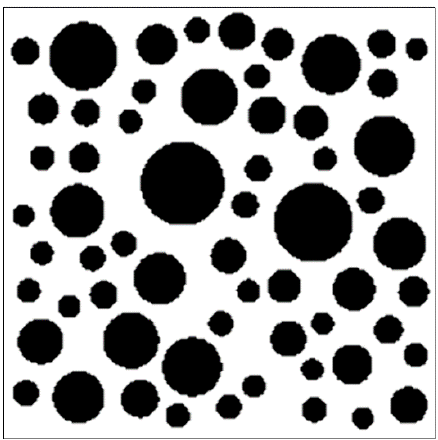
Figure 6. The reconstructed bi-dispersed porous media based on the Random Circles Packing (RCP) algorithm.